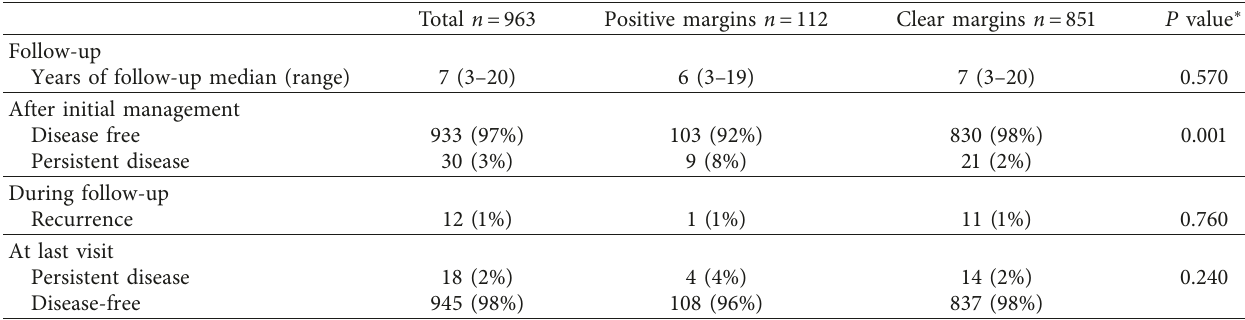
Table 4: Outcomes, positive versus clear margins, T1 and T2 stage.